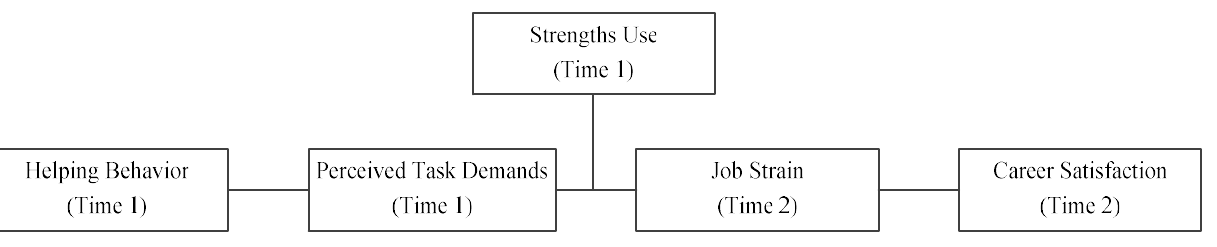
Figure 1. Conceptual model.